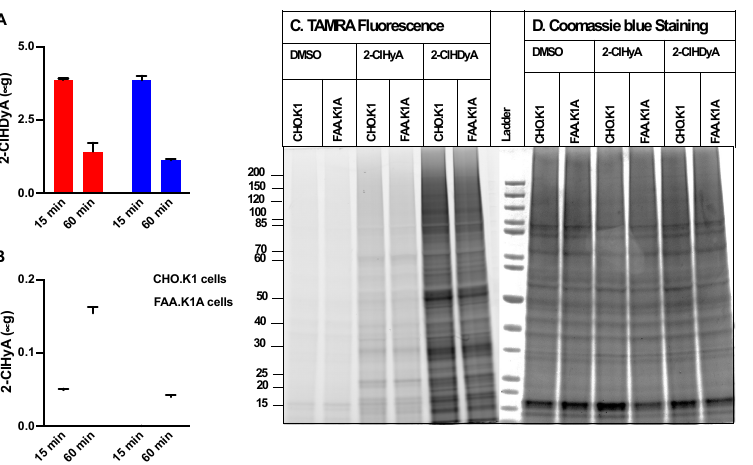
Figure 1. 2-ClHDyA metabolism and protein modification in CHO.K1 and FAA.K1A cells. CHO.K1 and FAA.K1A cell lines were treated with 10 μ M 2-ClHDyA for indicated time intervals. At the end of each time point, cellular and media lipids were extracted together, and 2-ClHDyA ( A ) and 2-ClHyA ( B ) were quantitated as described in “Materials and Methods”. Values are average + SEM for n = 3 in both A and B; ( C ) CHO.K1 and FAA.K1A cells were treated with either DMSO, 10 μ M 2-ClHyA, or 10 μ M 2-ClHDyA for 1 h at 37 °C. Proteins modified by these ω -alkyne chlorolipids were clicked with TAMRA-azide and were visualized after gel electrophoresis; ( D ) Coomassie blue staining of gel protein loads used for TAMRA fluorescence analyses.